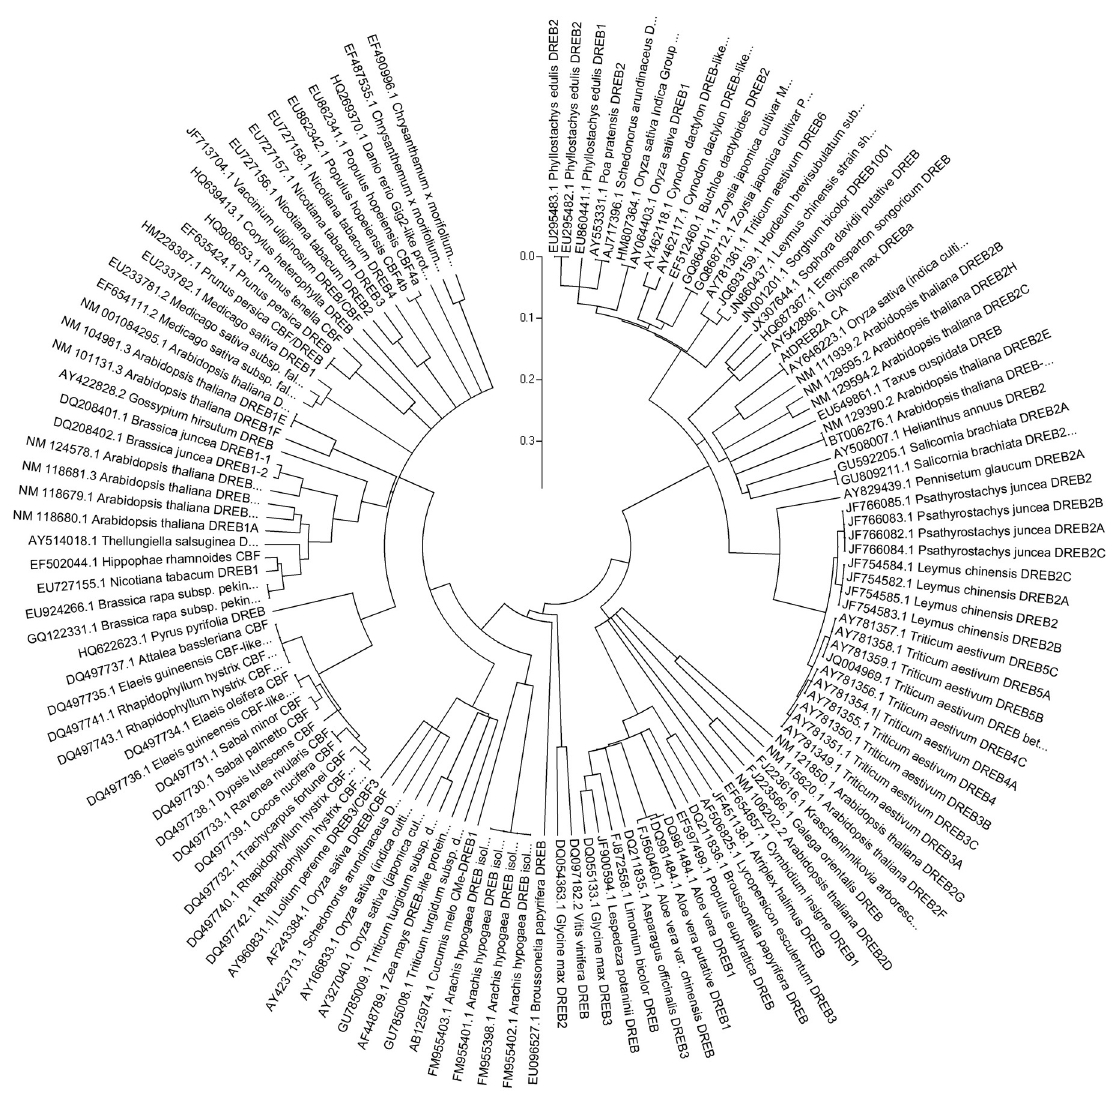
Figure 2 - Phylogenetic tree generated from the DREB-coding DNA sequence (CDS) from various plant species. The sequences were obtained from the NCBI website and were aligned and clustered using Clustal X and MEGA 4.0,